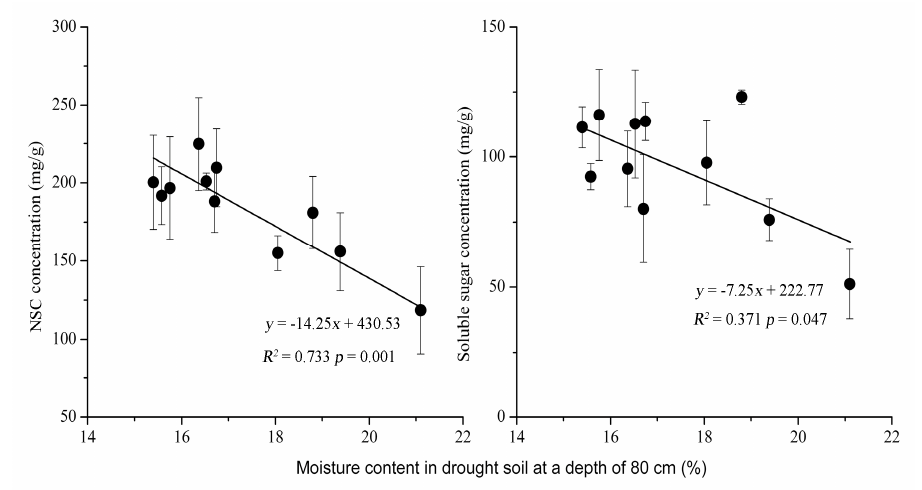
Figure 8. Relationships between NSC concentrations and soluble sugar in leaves and deep soil (80 cm) moisture content in the drought treatment.